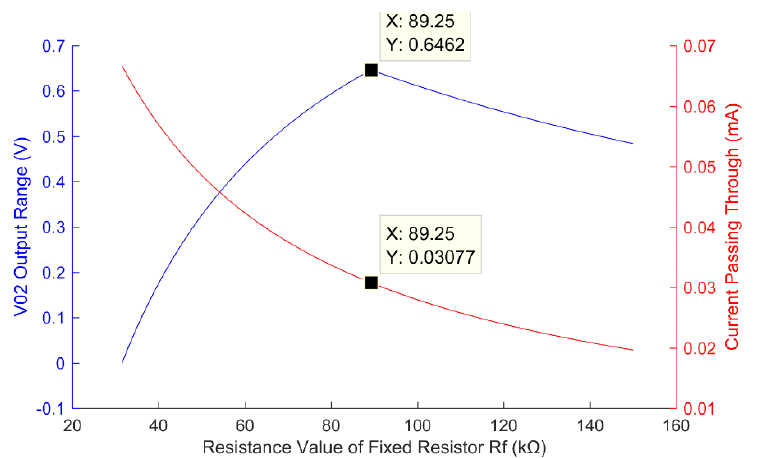
Figure 6. Relationship curves between the output range (blue line) and circuit loss (red line) of the transducer grounding bleeder circuit and the resistance value of the fixed